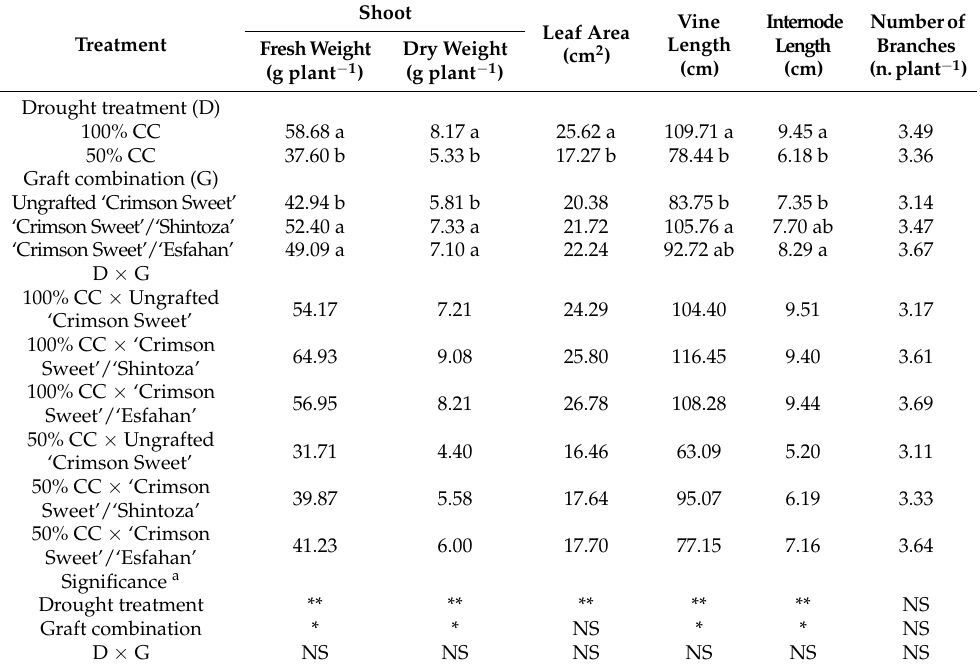
Table 1. Effects of graft combination and drought treatment on shoot fresh and dry weight, leaf area, vine length, internode length and number of branches of watermelon plants.